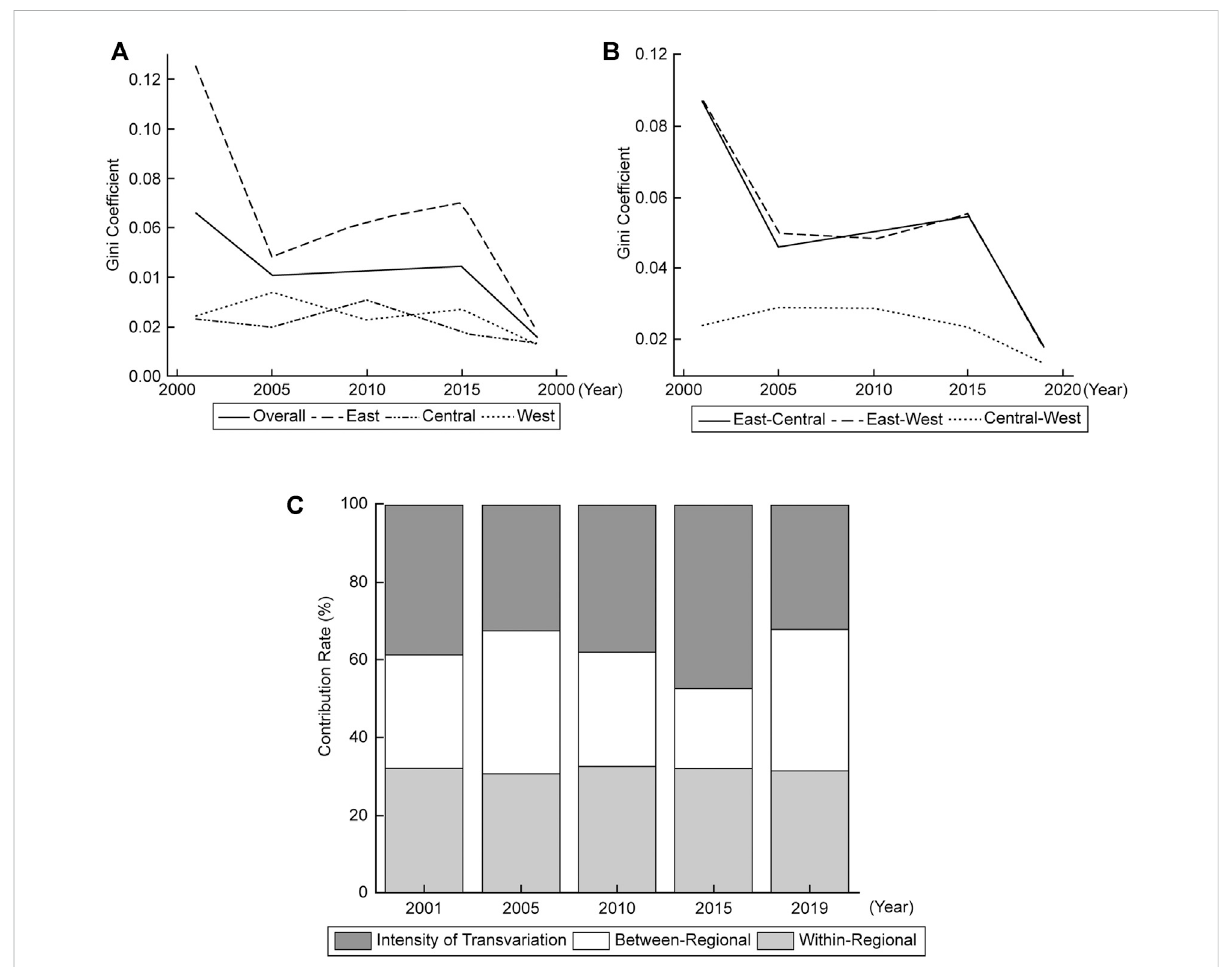
FIGURE 1 Evolution of theGini coef fi cient for GTFP differences inChina and thecontributions of each Gini component. Notes: (A) Temporal evolution of Gini coef fi cients at the national and within-region levels; (B) Temporal evolution of Gini coef fi cients at the between region level; (C) Sources of regional GTFP quality and their